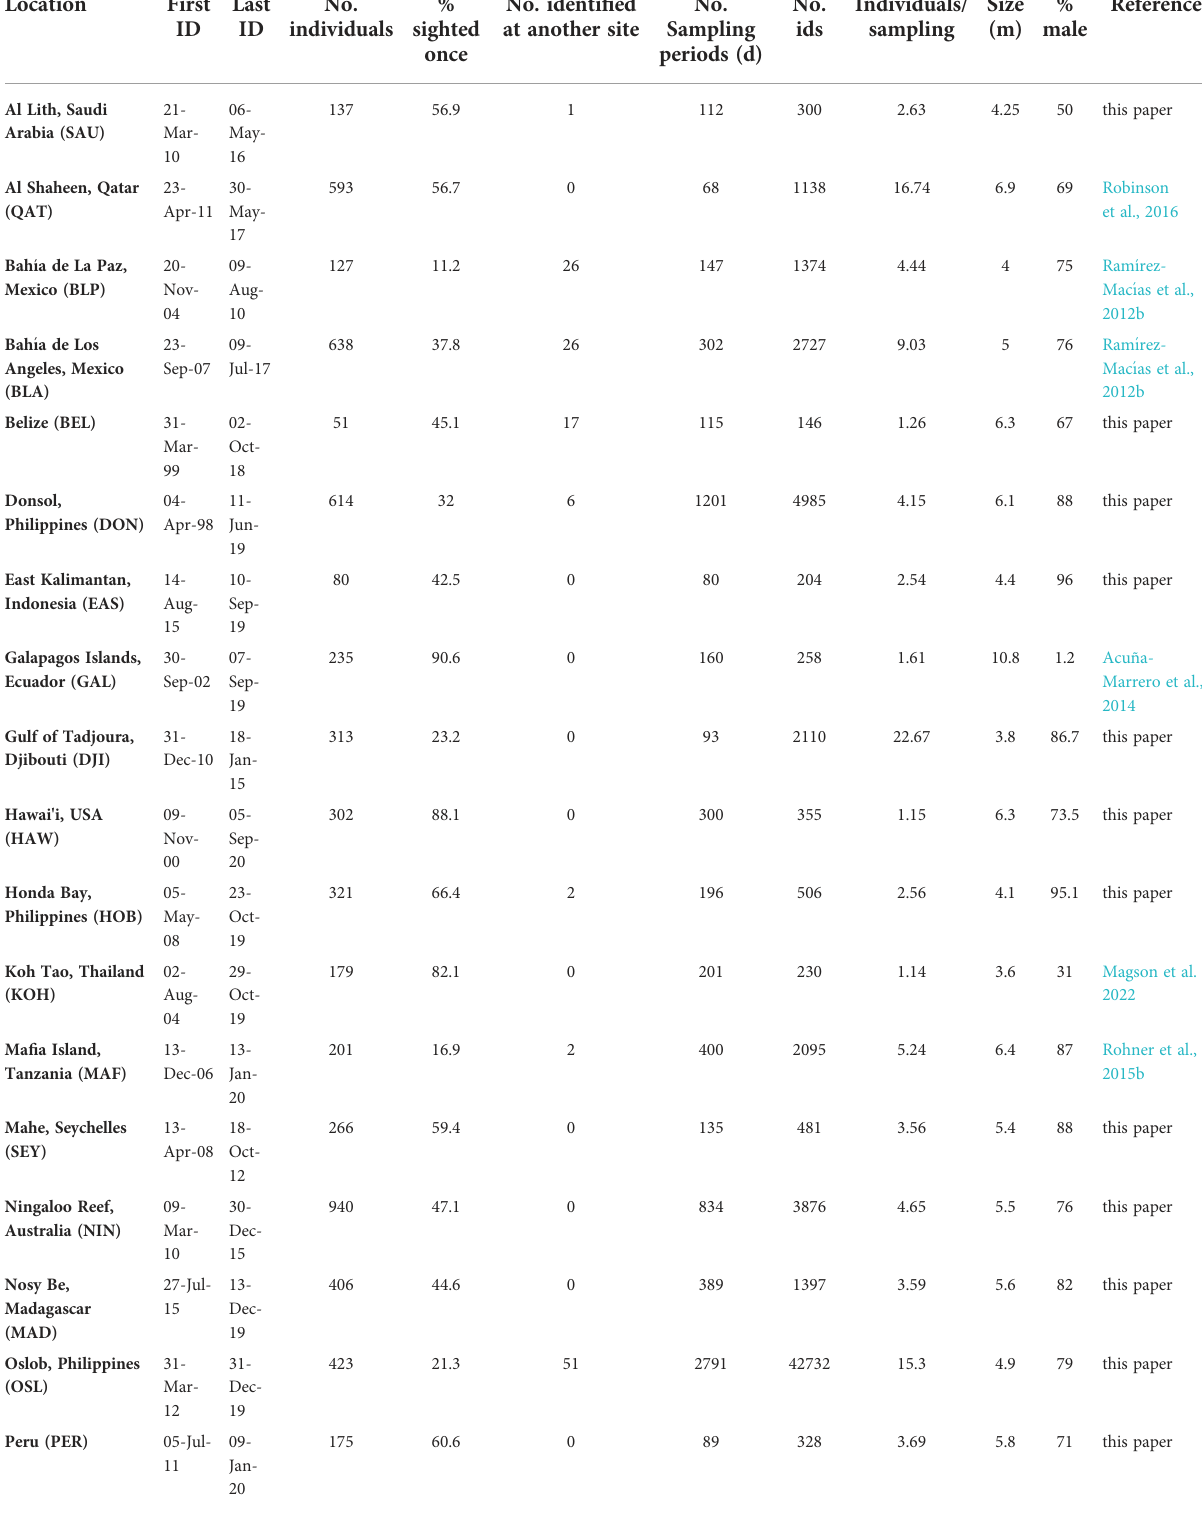
TABLE 1 Data summary for all 25 sites in this study.